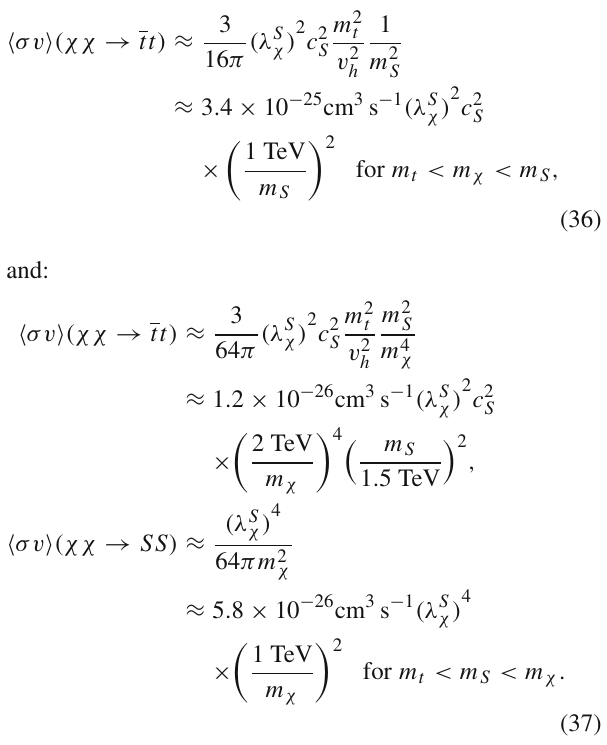
DM relic density are represented by red bands. The blue, magenta and purple regions represent the current exclusion and the projected sensi- tivity of XENON1T (assuming 2 years of exposure time in the latter case) and LZ,